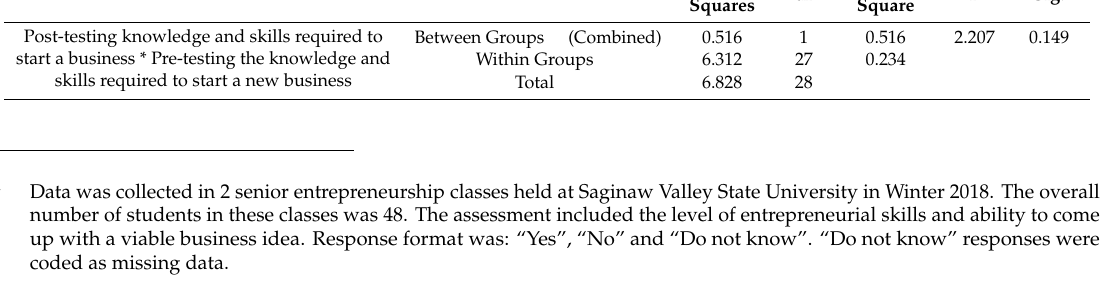
Sum of Mean df F Squares Square